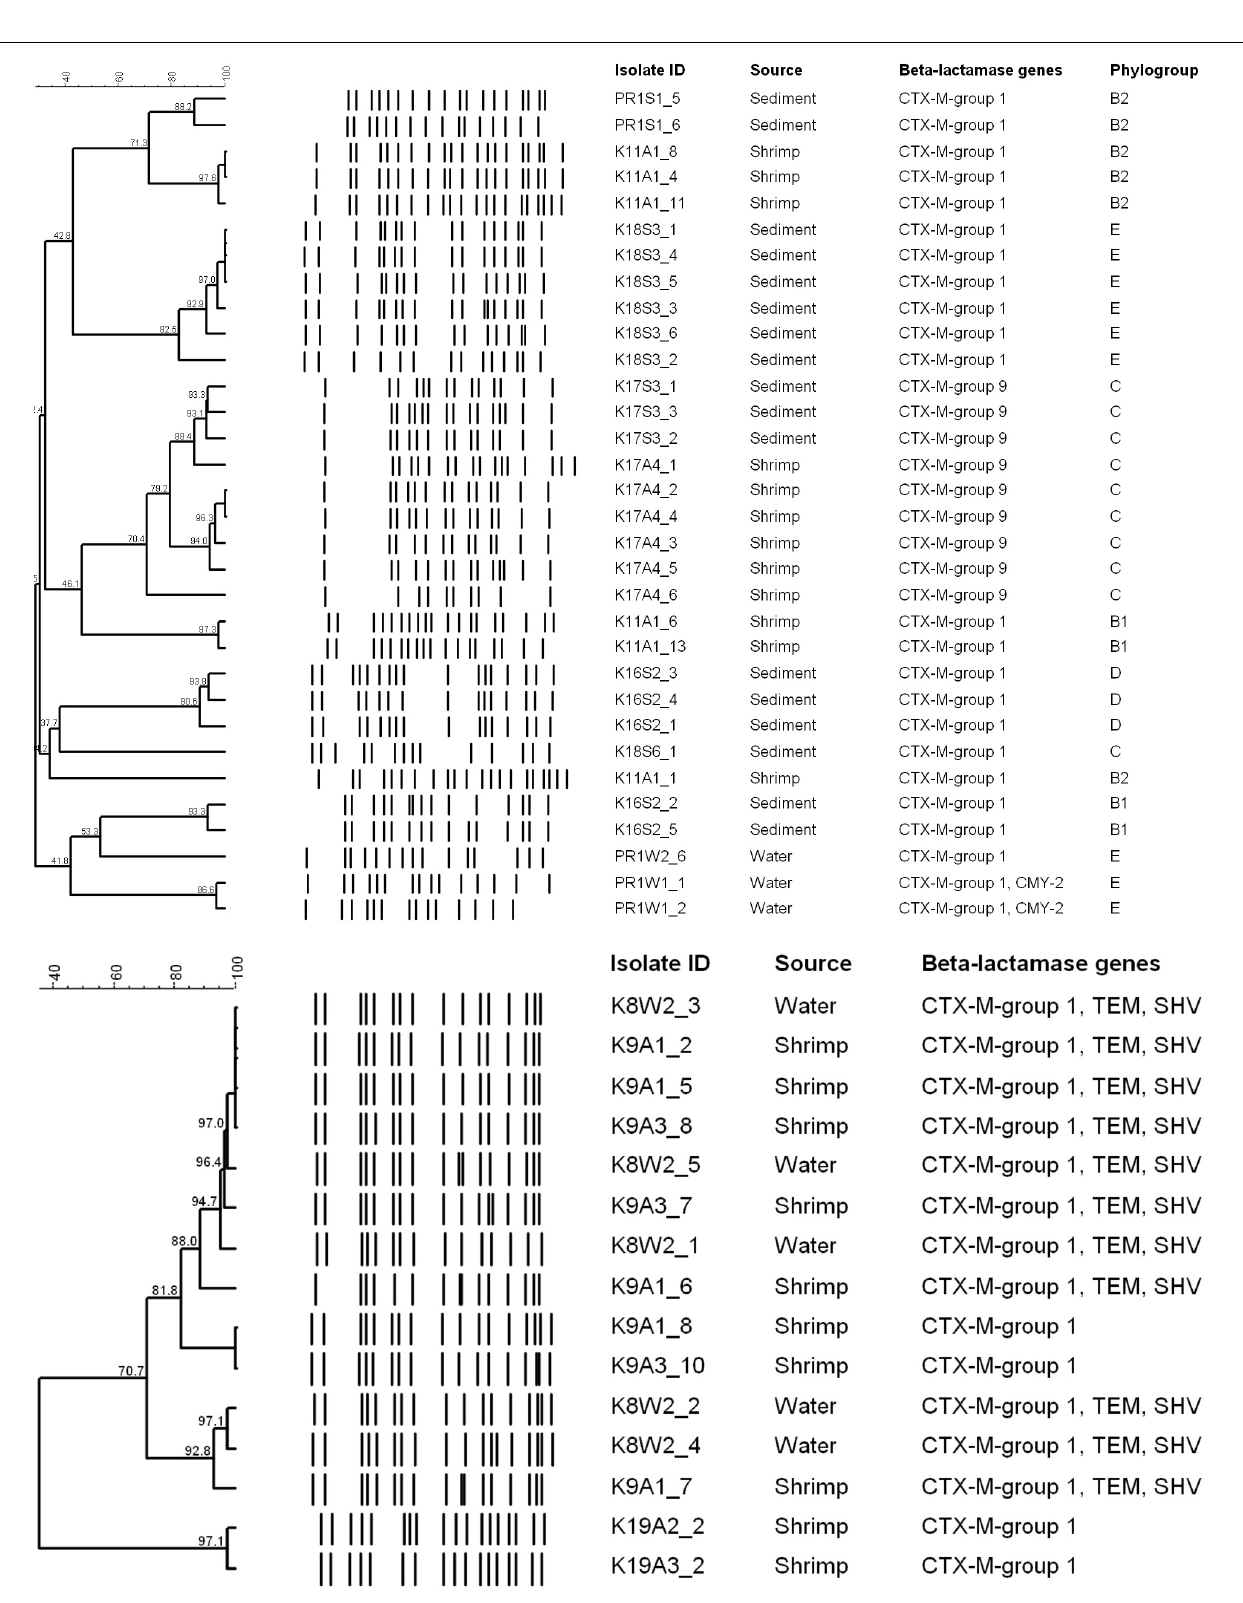
Frontiers in Microbiology |